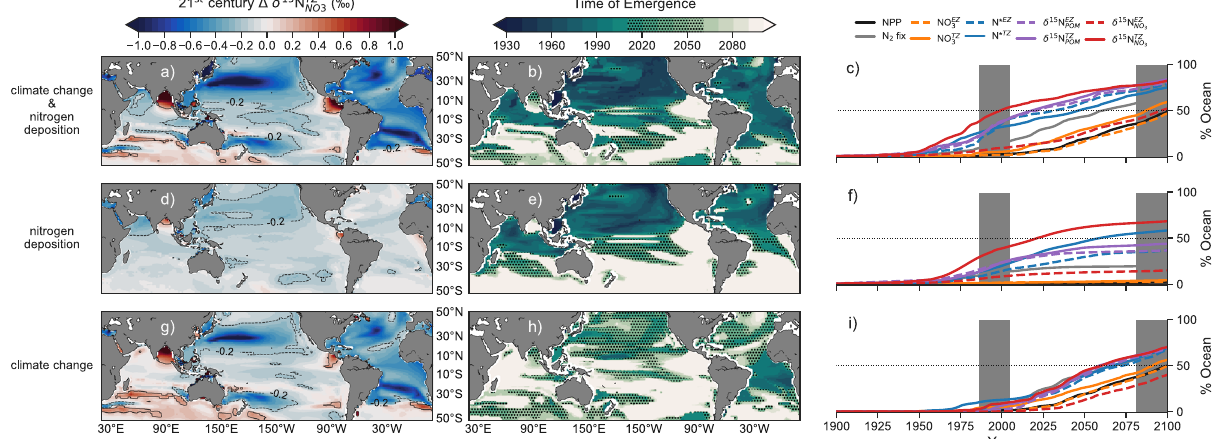
Fig. 2 Anthropogenic trends of nitrogen isotopes in the twilight zone and their Time of Emergence. a End of twenty- fi rst century (2081 – 2100) minus turn of the century (1986 – 2005) twilight zone δ 15 N NO3 due to both anthropogenic drivers. b Time of Emergence of twilight zone δ 15 N NO3 . c Percentage of the low-latitude ocean (45°S – 45°N) with emergent trends in biogeochemical variables related to the marine nitrogen cycle. They include vertically integrated net primary production (NPP) and nitrogen fi xation (N 2 fi xation), nitrate (NO 3 ) concentrations in both the euphotic zone (EZ) and twilight zone (TZ), δ 15 N NO3 and δ 15 N POM . d – f Same as a – c but for experiment with nitrogen deposition only. g – i , Same as a – c but for experiment with climate change only.